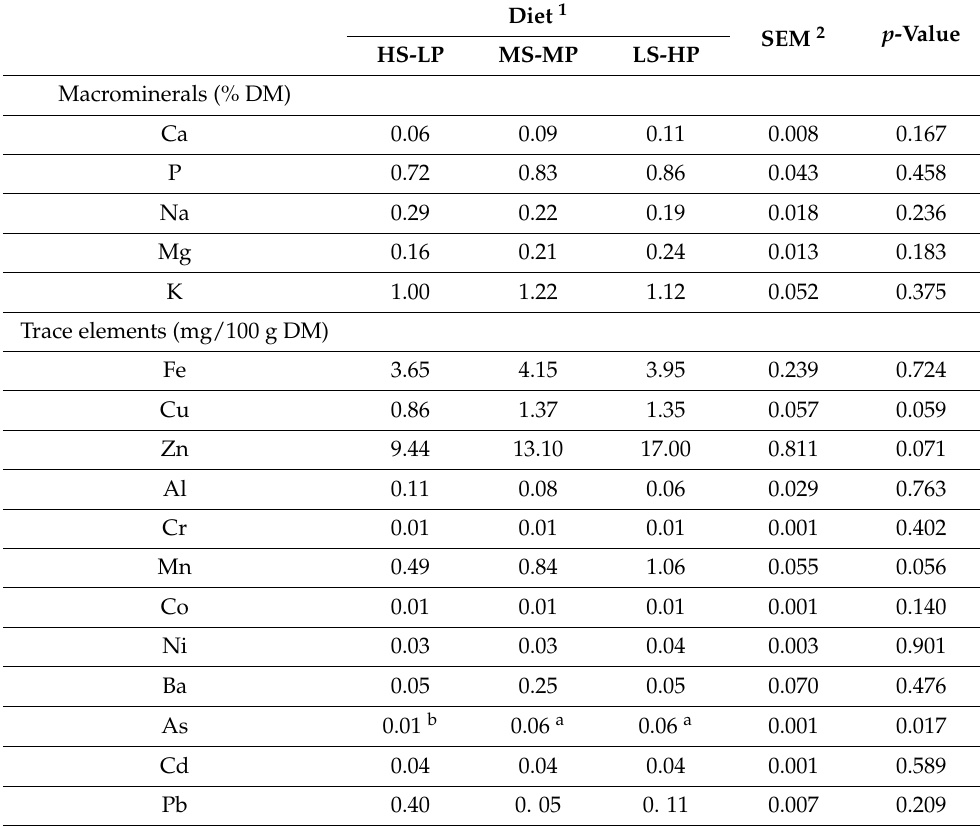
Table 5. Effects of the diets on the mineral composition of Tenebrio molitor